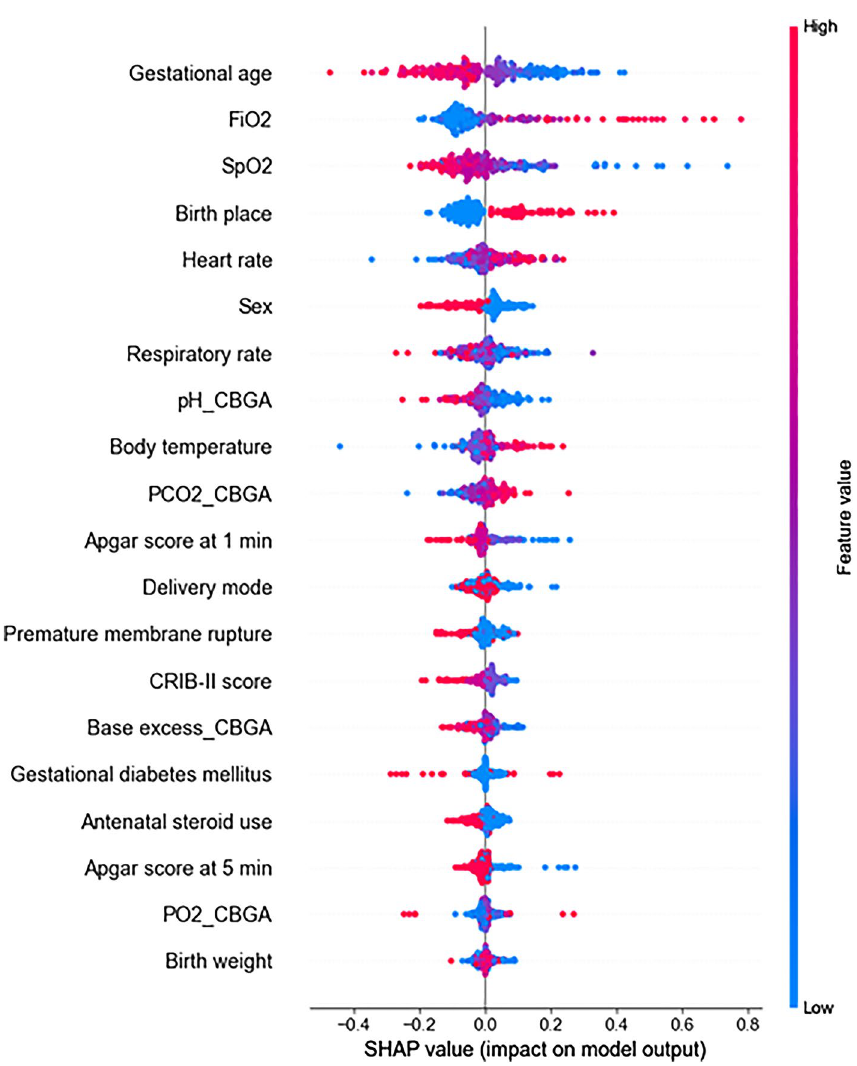
Figure 6. Feature importance assessment with Shapley additive explanations (SHAP) values. The most crucial features associated with the predictive power of the model were gestational age, fraction of inspired oxygen, pulse oximetry, birthplace, and heart